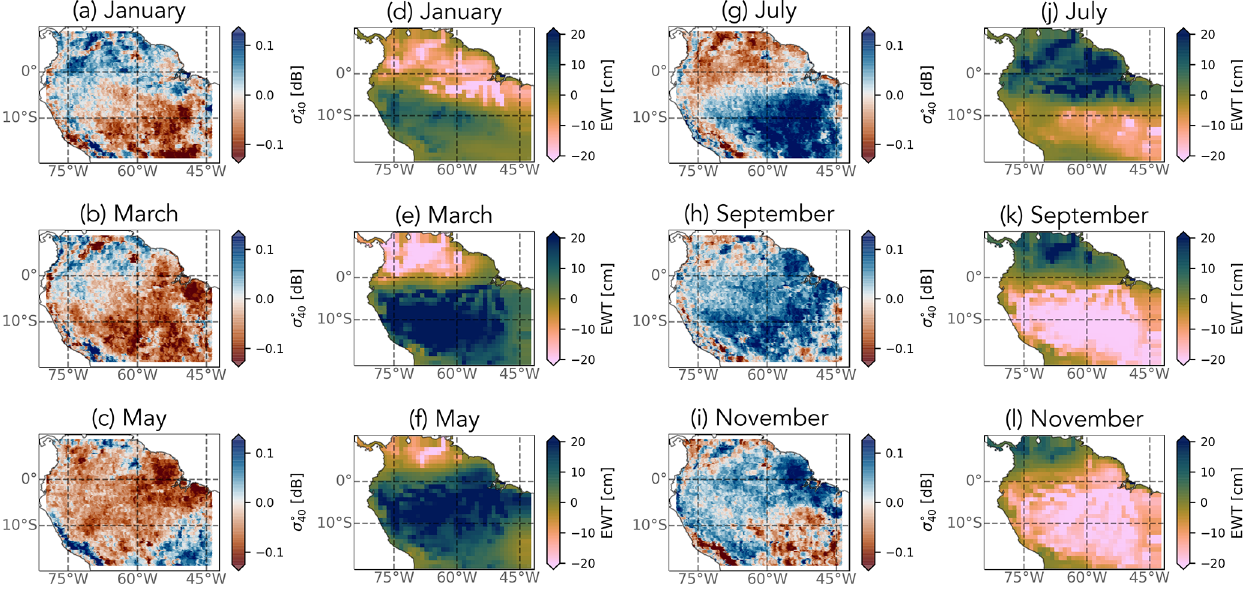
Figure 12. Maps of monthly mean diurnal differences in σ o ness (EWT) from GRACE for different months in the